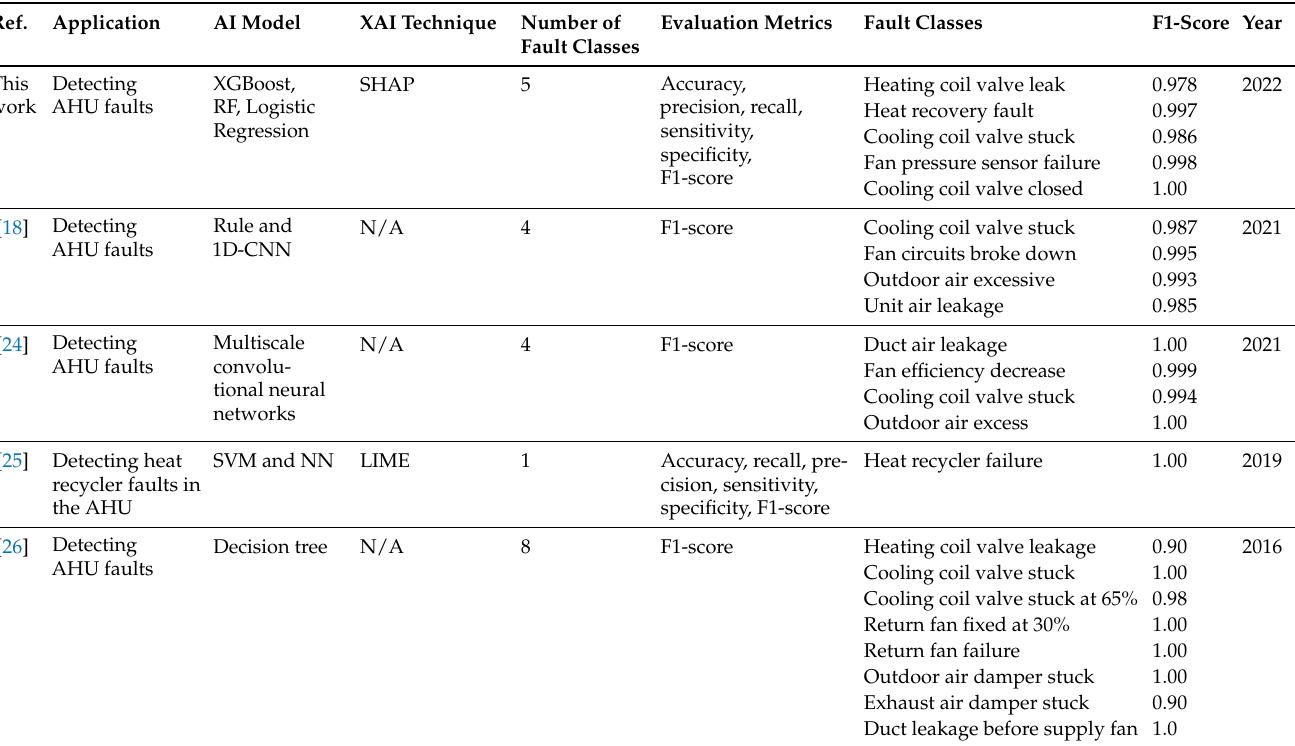
Table 1. The summary of FDD methods, fault classes, and the numerical results of the best-performing methods for each study for air-handling units in the literature. Ref.